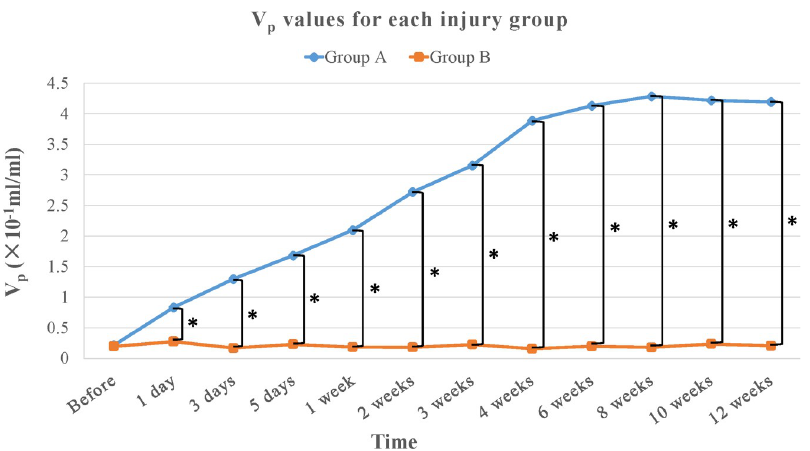
Fig 2. Graph shows the time course of V p values for each injury group. There were significant differences between irreversible neurotmesis group (group A, blue line) and control group (group B, orange line) after surgery ( P < 0.05). � = P <